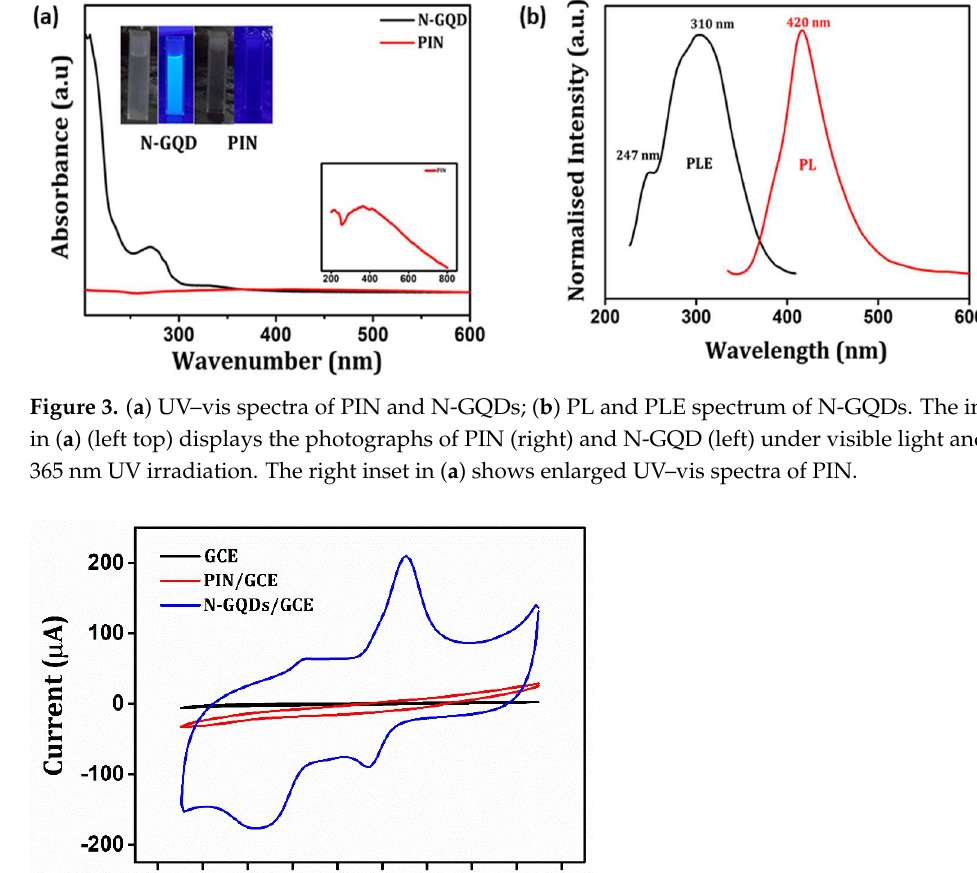
Figure 4. Comparison of CV scans obtained for GCE, PIN/GCE, and N-GQDs/GCE for 0.1 mM DA in 0.1 M PBS at 100 mV s −1 .